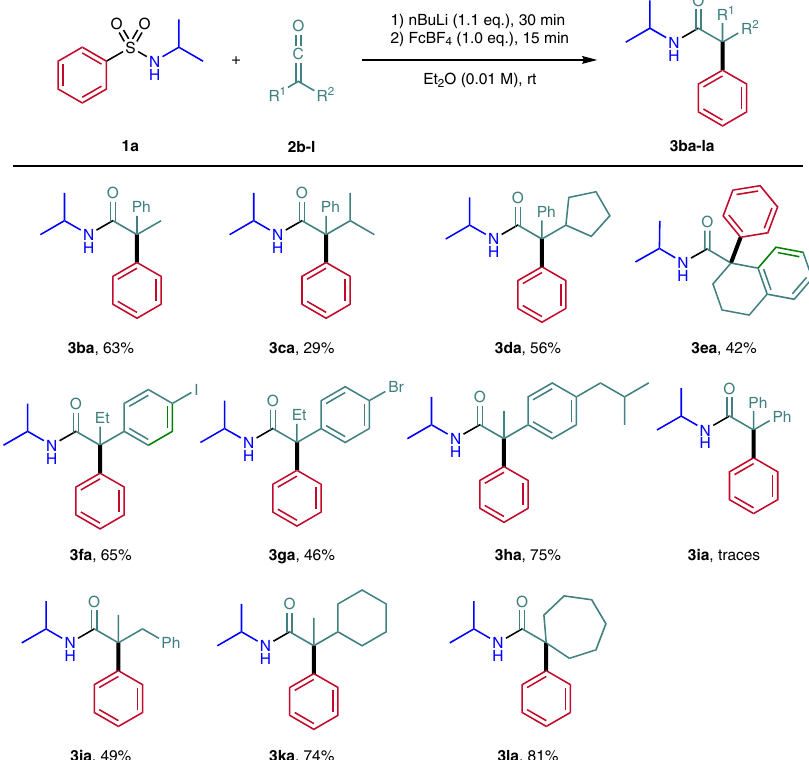
Fig. 4 Variation of the ketene. Reaction scale: 0.200 mmol. Ketene 2 in Et 2 O (0.06 M ) over 30 min by syringe pump. FcBF 4 = Ferrocenium tetra fl uoroborate.